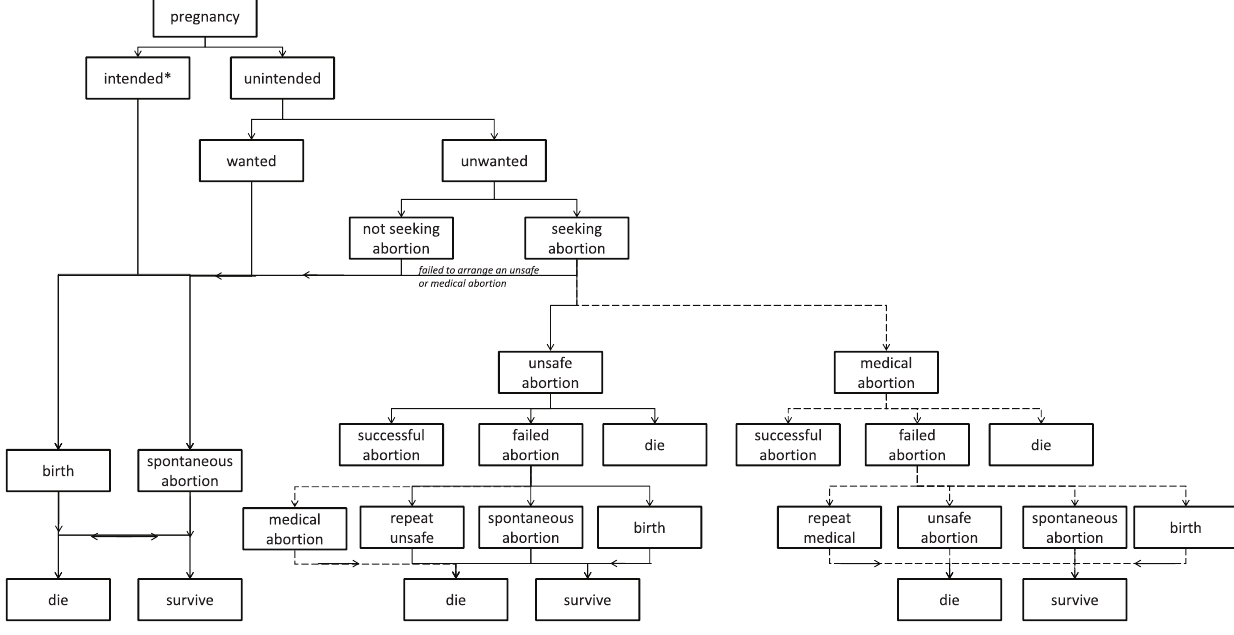
Figure 1. Decision tree of outcomes of pregnancy according to whether medical abortion services are available. Solid lines represent choices available to all women; dotted lines represent choices available to women where medical abortion services are available. * Some intended